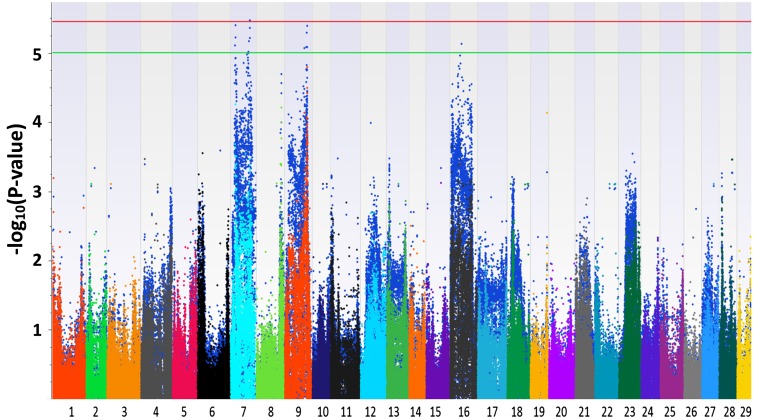
Manhattan plots for head length. The plots in different colors in the front layer were generated from EMMAX (Efficient Mixed-Model Association eXpedited) and the plots in blue in the back layer were generated from QFAM (family-based association test for quantitative traits).